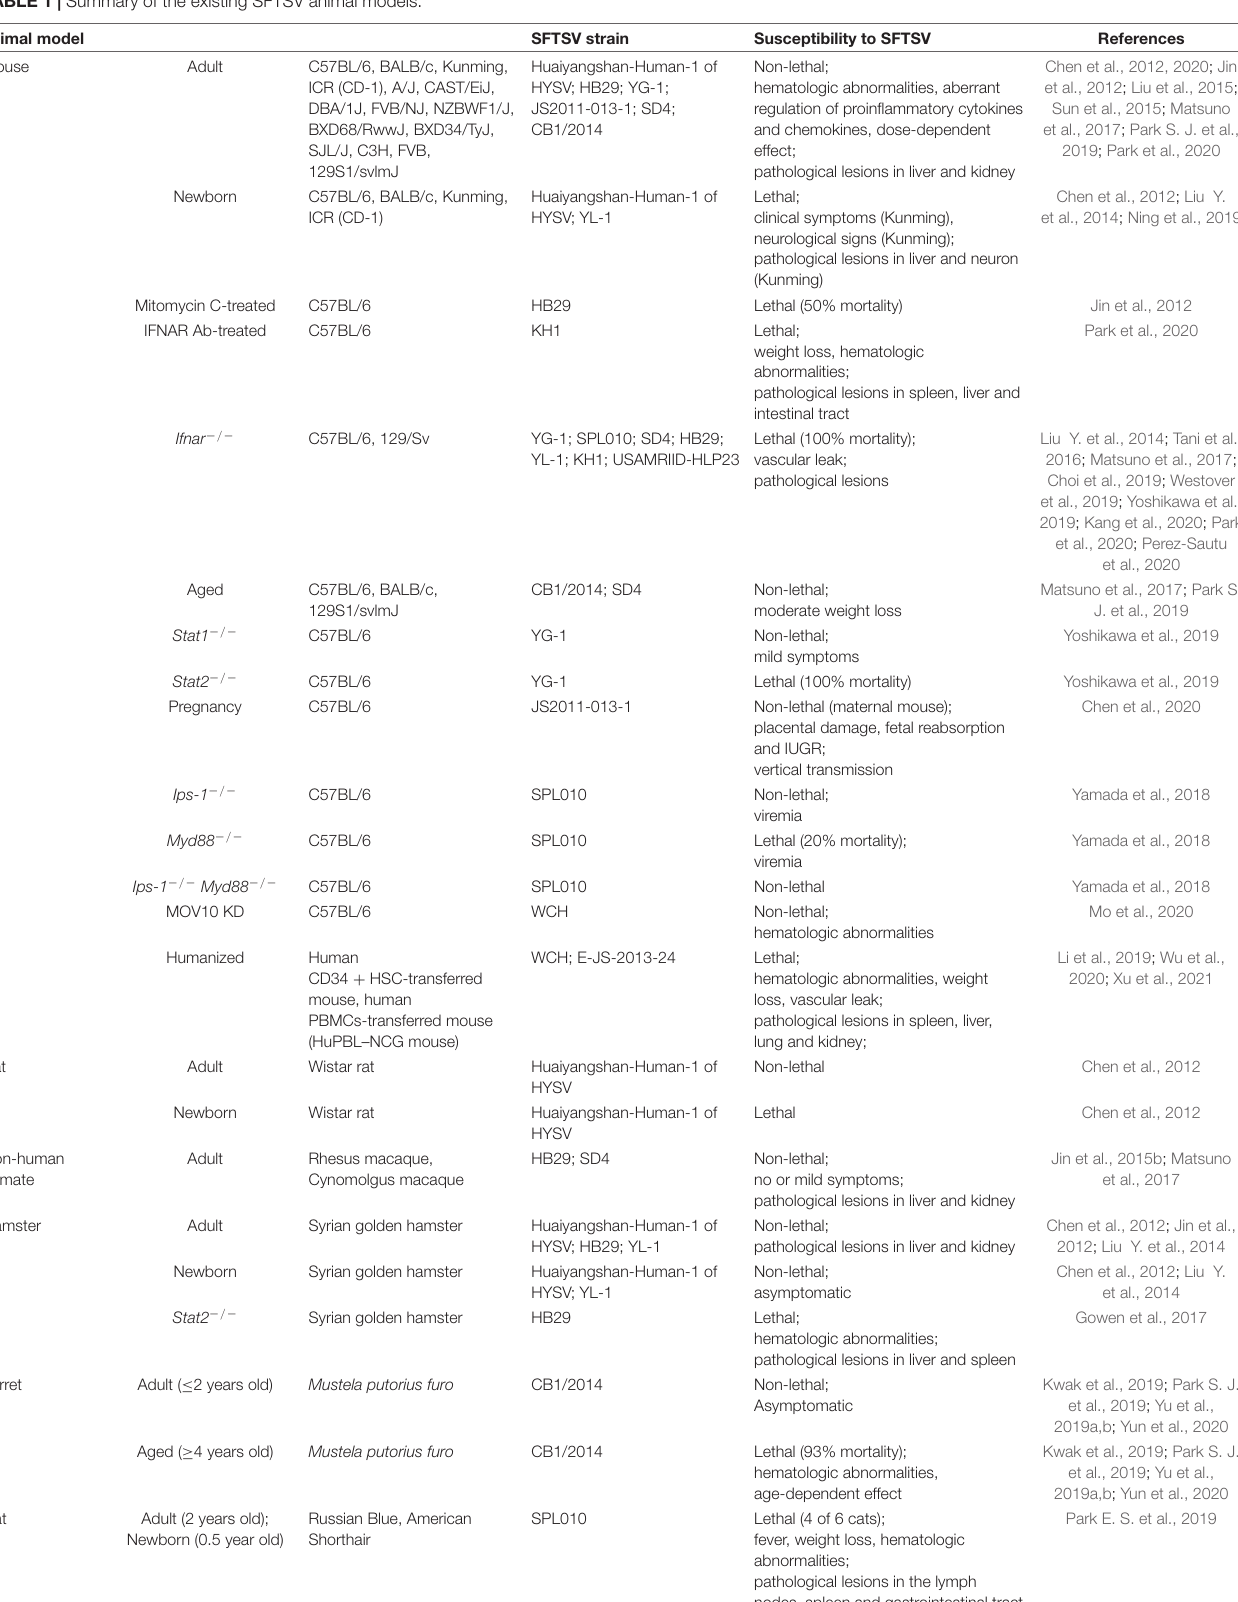
TABLE 1 | Summary of the existing SFTSV animal models. Animal